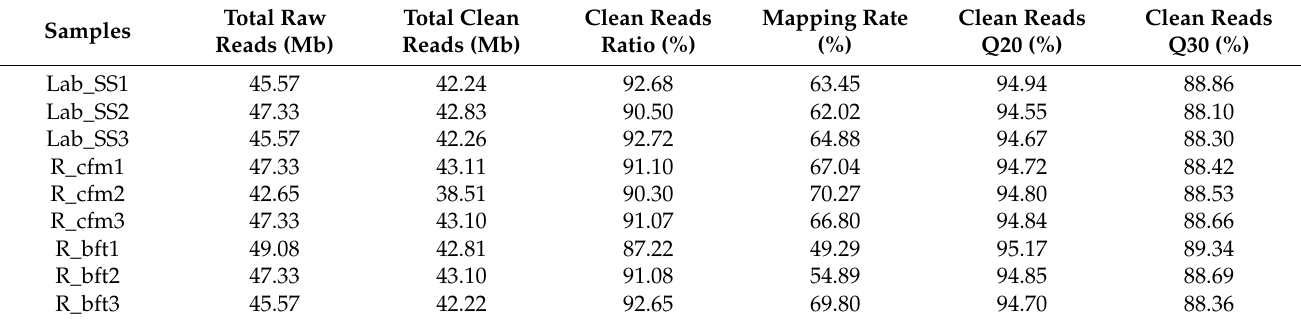
Table 2. Summary of the RNA sequencing and assembly of T. urticae.